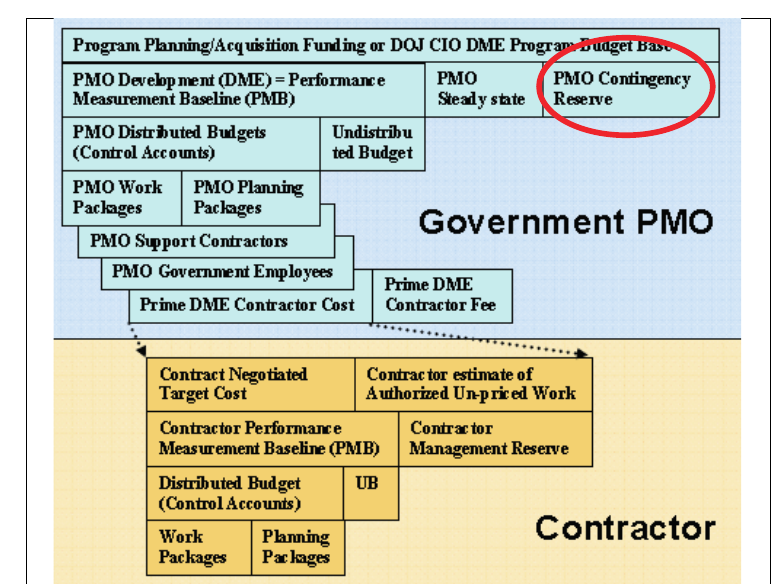
Fig. 8. Program budgets (DOJ, 2010: